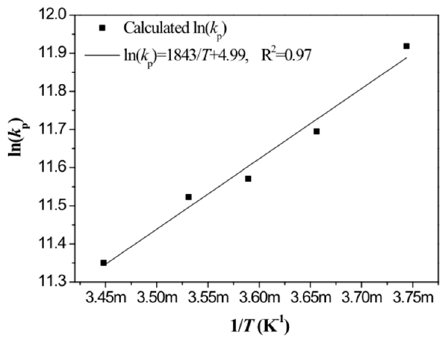
Figure 4. Arrhenius plot of ln k p versus 1/ T for the cationic polymerization of IB in RPB.